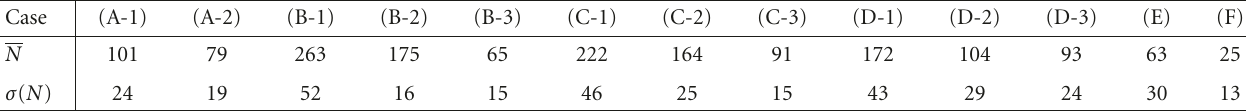
Table 1: Mean N and standard deviation σ ( N ) of the ATF model order (over the set of eleven ATFs) for the di ff erent cases and configurations.